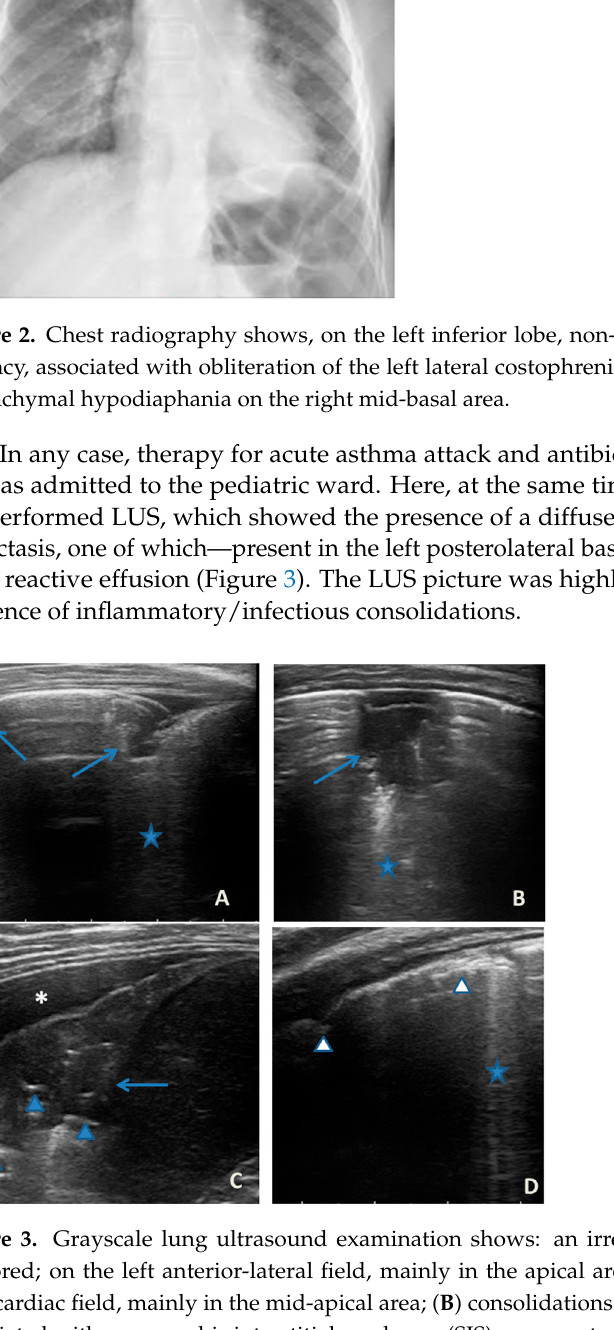
Figure 2. Chest radiography shows, on the left inferior lobe, non-specific areas of reduced transpar- ency, associated with obliteration of the left lateral costophrenic sinus. It shows further subtle paren- chymal hypodiaphania on the right mid-basal area.